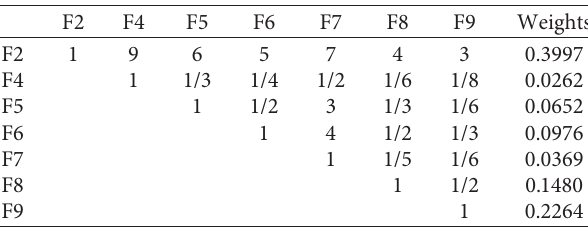
Table 4: Pairwise comparison matrix and relative importance weights of the factors associated with solar